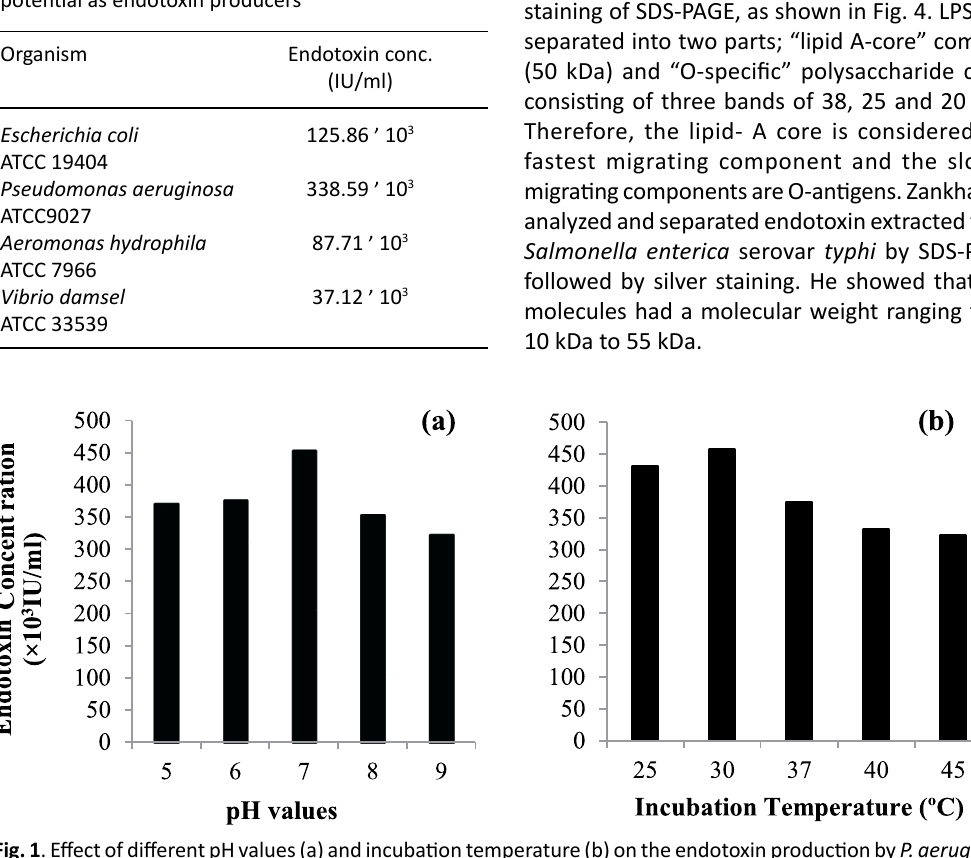
Table 1. Selected Gram-negative bacteria and